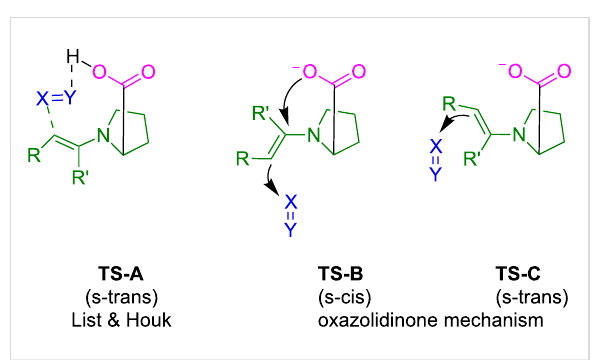
Figure 20: Proposed transition states for the stereogenic step in proline-catalyzed reactions.